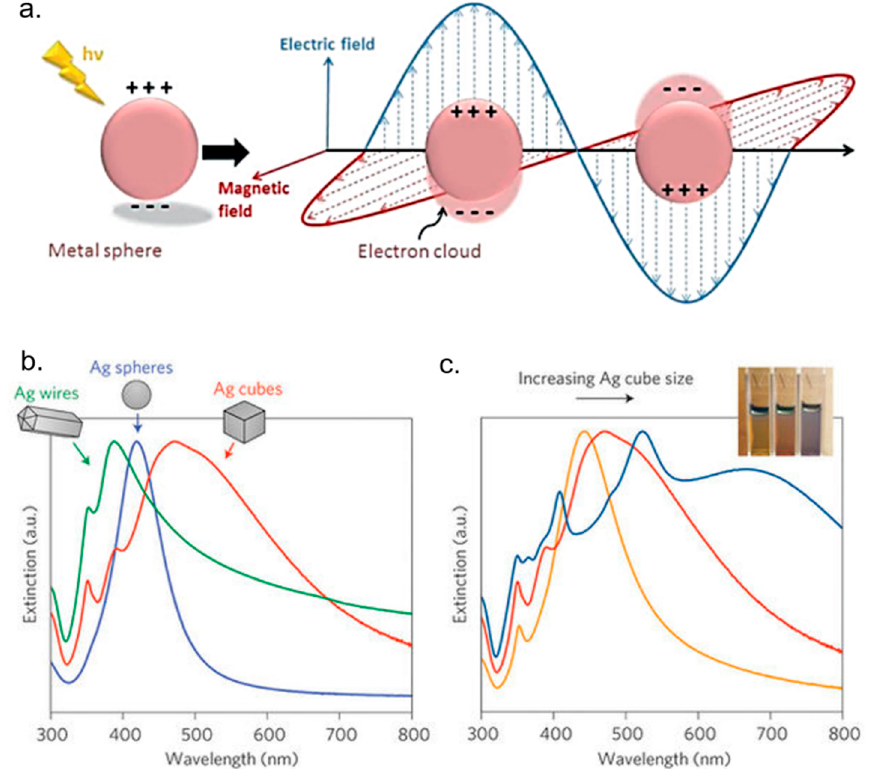
Figure 4. ( a ) Schematic representation of a localized surface plasmon resonance (LSPR), reproduced from [153] with permission of The Royal Society of Chemistry. ( b , c ) The change of shape and size exhibited different extinction properties. Adapted from [154] with permission from Macmillan Publishers (Nature Materials), 2015.